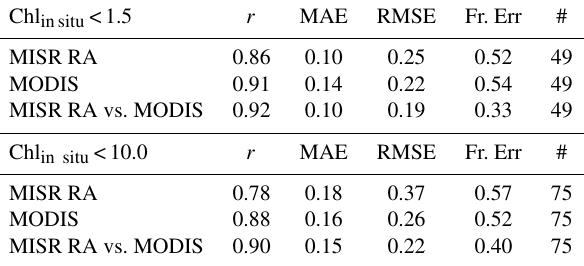
Table 1. Statistics of chlorophyll a retrievals as compared to SeaBASS. In this table, r is the Pearson correlation coefficient, MAE is the median absolute error, RMSE is the root-mean-square error between the satellite retrieval and in situ data, Fr. Err is the mean absolute fractional error of the retrieval with respect to the measurement, and # is the number of validation cases included. The last row for Chl insitu <1.5 and Chl insitu <1.5 represents the statis- tics of MISR vs. MODIS. Chl insitu <1.5